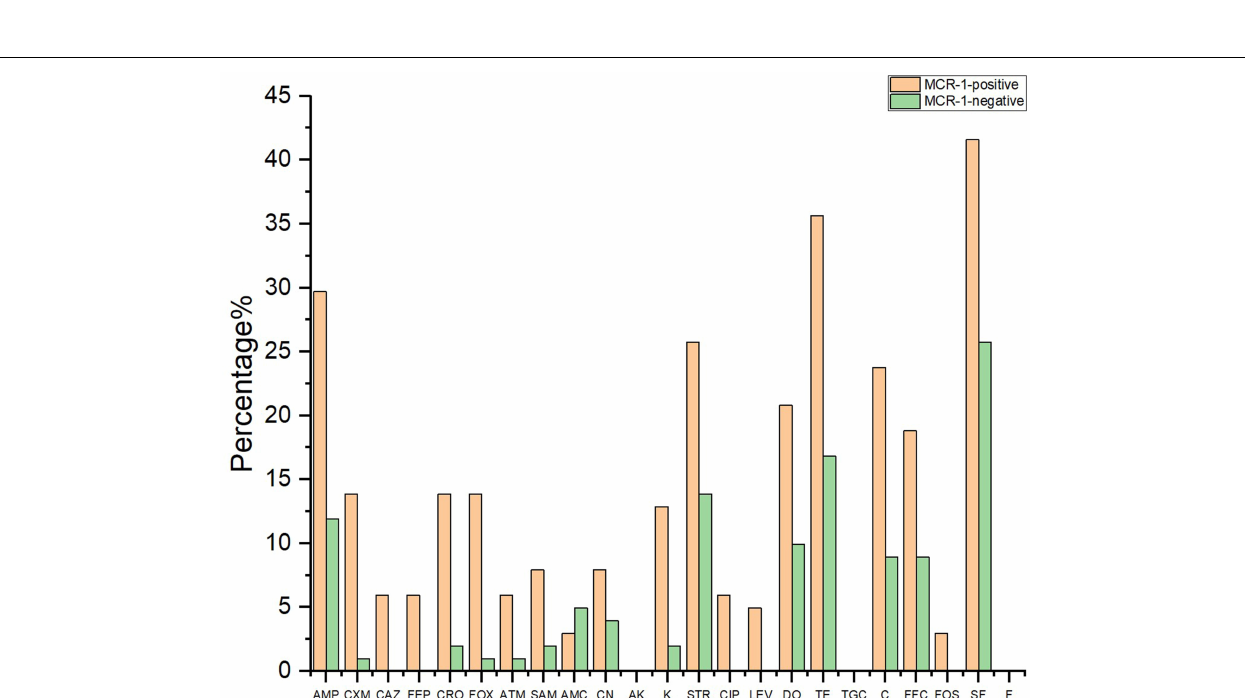
Frontiers in Microbiology |